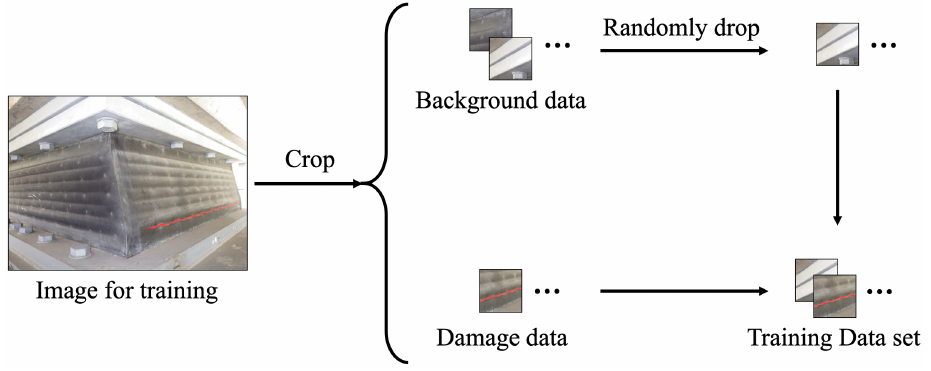
Figure 11. Process of dropping background data.